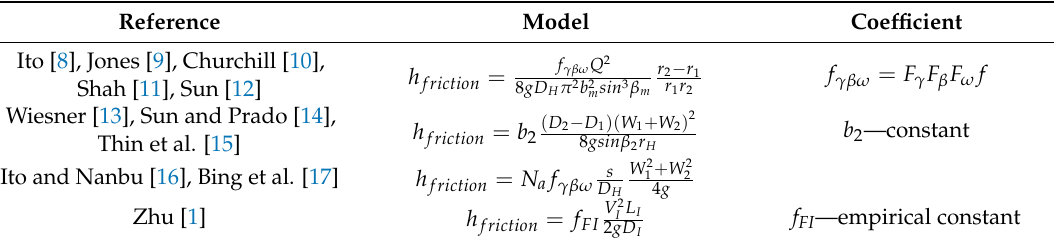
Table 1. Friction loss models in literature.